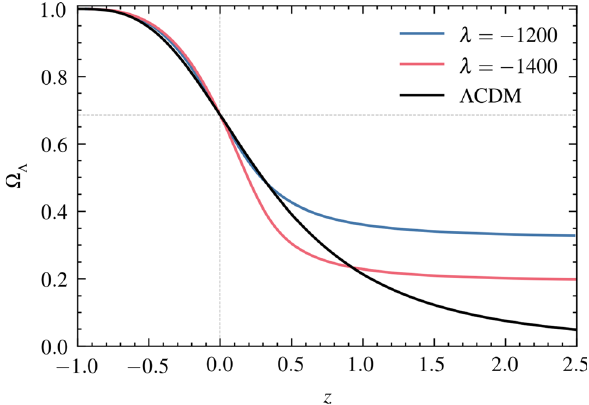
Fig. 6 Darkenergydensityparameter( (cid:12) (cid:2) )asafunctionofredshift( z ) for different values of λ (with (cid:12) m 0 = 0 . 315 and H 0 = 67 . 4 km/s/Mpc